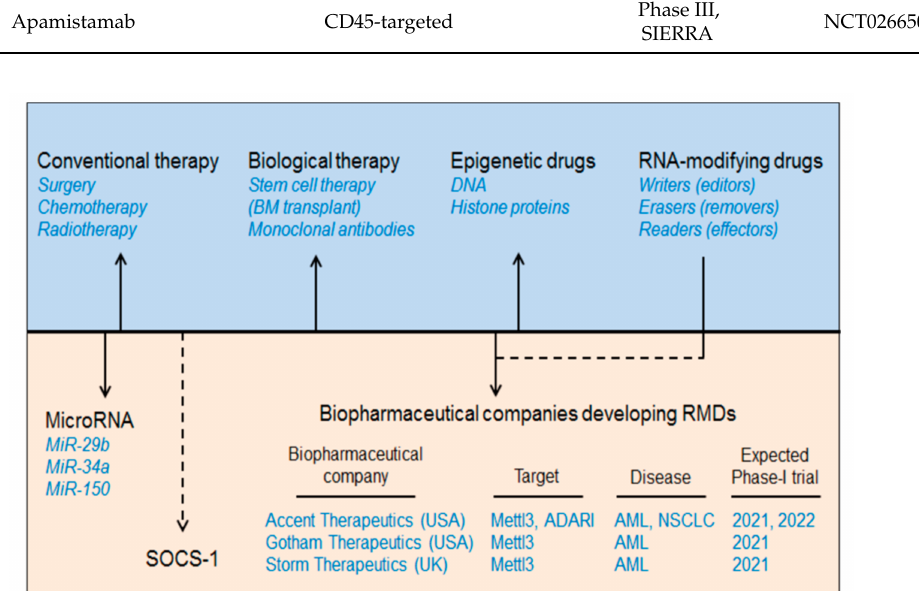
Figure 1. Development of AML therapeutics. The major AML therapeutics are depicted in the diagram above which includes conventional therapy (chemotherapy, radiotherapy, and surgery), biological therapy (stem cell therapy or bone marrow transplant), epigenetic drugs (DNA and histone modifier-based drugs), RNA-modifying drugs (writers/editors, erasers/removers, and read- ers/effectors), microRNAs (miR-29b, miR-34a, and miR-150) and suppressor of cytokine signalling (SOCS1/CISH). Additionally, we have mentioned some biopharmaceutical companies developing RMDs and estimated phase-I clinical trials. ATRA: all-trans retinoic